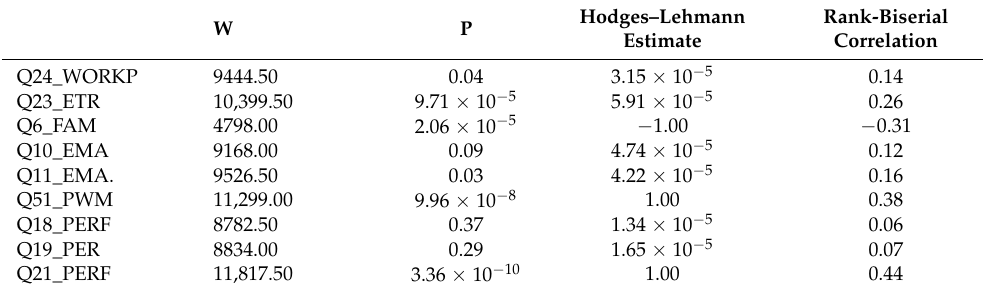
Table 4. Mann–Whitney test parameters for selected questionnaire items. Example of the item coding system: QXX_ETR = Q (question) × X (item order in the questionnaire), _ETR (item-related driver). For the Mann–Whitney test, the location parameter is given by the Hodges–Lehmann estimate. Levene’s test is significant ( p < 0.05), suggesting a violation of the equal variance assumption (it may determine a bias in the interpretation).